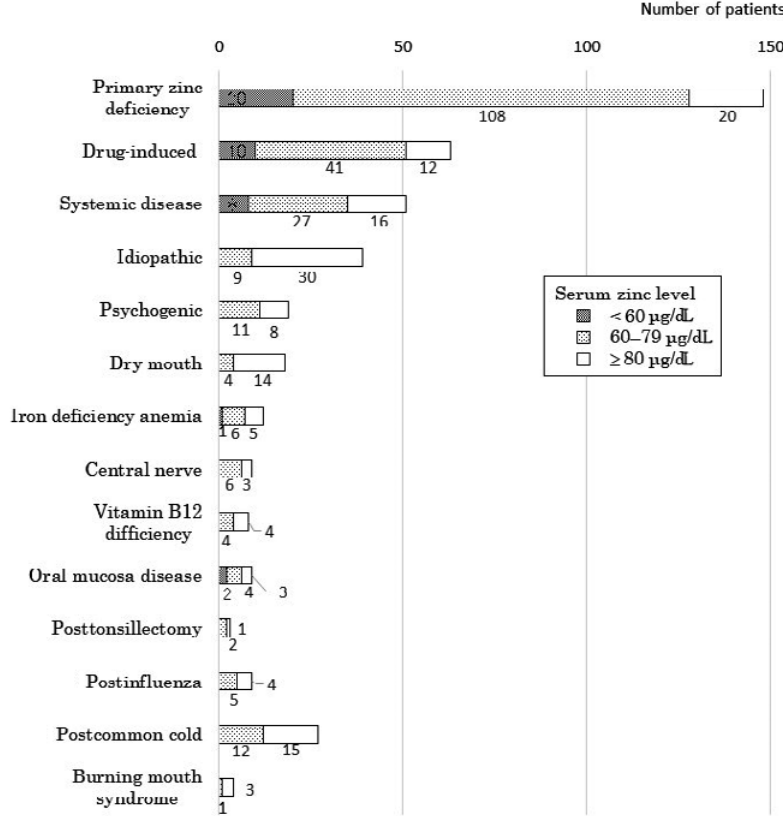
Figure 5. Distribution of serum zinc levels as a function of the cause of taste disorders. In the 148 patients diagnosed with primary zinc deficiency as the cause, the serum zinc level was < 60 μ g/dL in 20 patients (13.6%), and 60-79 μ g/dL in 108 patients (73.5%). By contrast, 20 patients (13.6%) who had already started zinc replacement therapy before visiting our facility had a high zinc level (≥ 80 μ g/dL). Among 257 patients remaining after excluding patients with primary zinc deficiency, 20 (7.8%) had a zinc level of < 60 μ g/dL while 125 (48.6%) had a level of 60-79 μ g/dL. The patients diagnosed with systemic or drug–induced taste disorders tended to have lower zinc